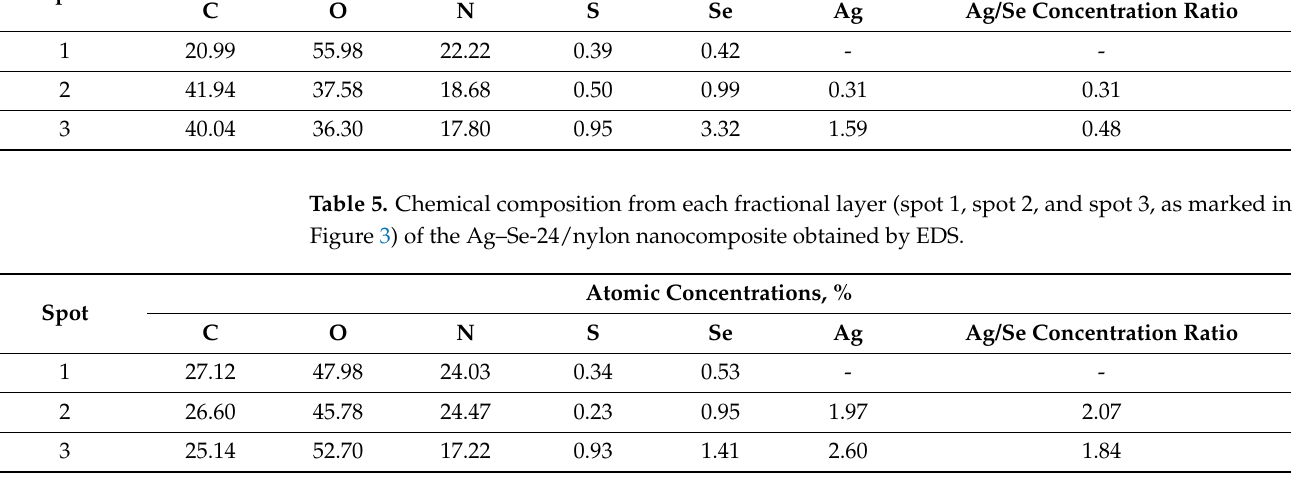
Table 6. Chemical composition from each fractional layer (spot 1, spot 2, and spot 3, as marked in Figure 3) of the Ag–Se-30/nylon nanocomposite obtained by